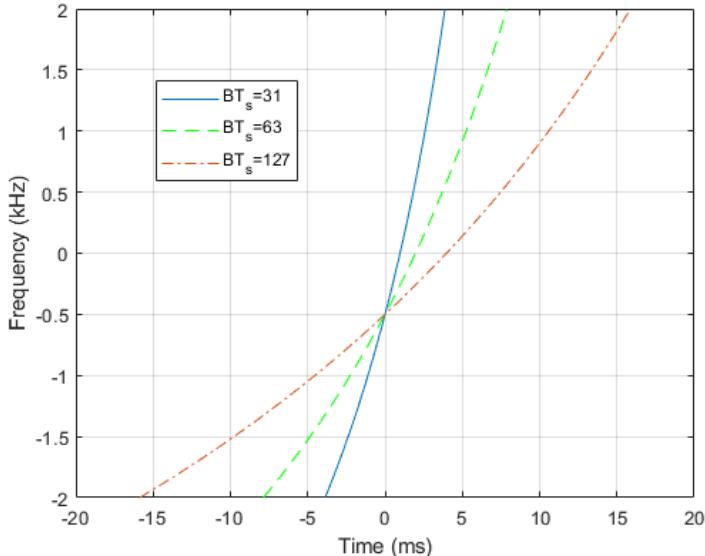
Figure 2. Instantaneous frequency of the Hyperbolically Frequency-Modulated (HFM) waveform with BT s = 31, 63,